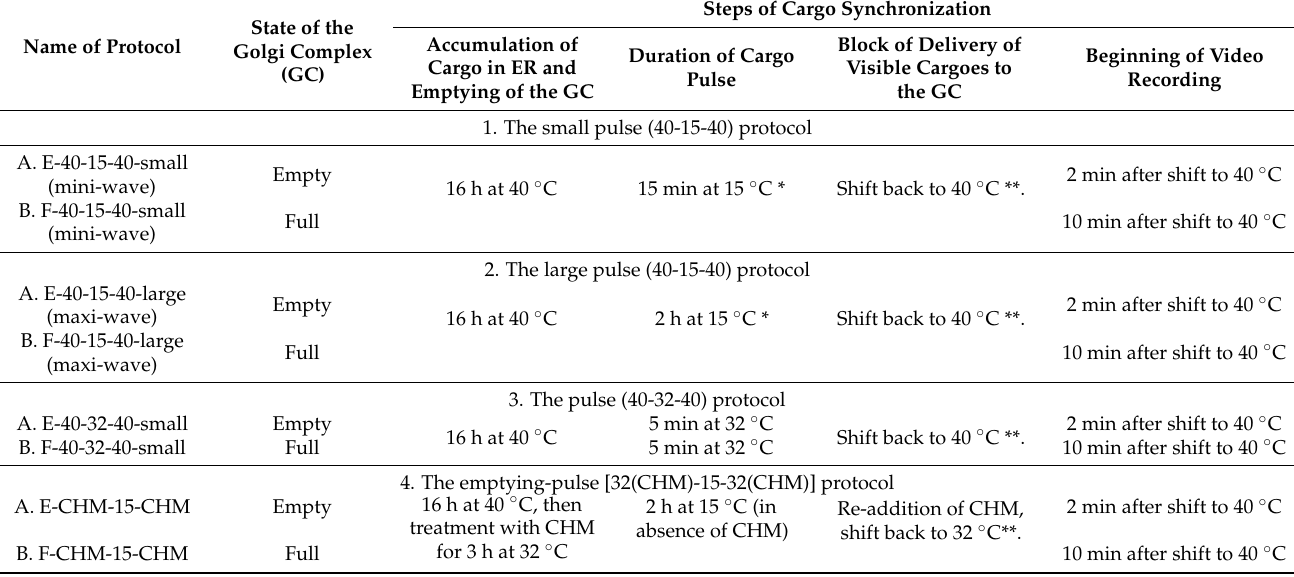
Table 1. Protocols for cargo synchronization during intra-Golgi